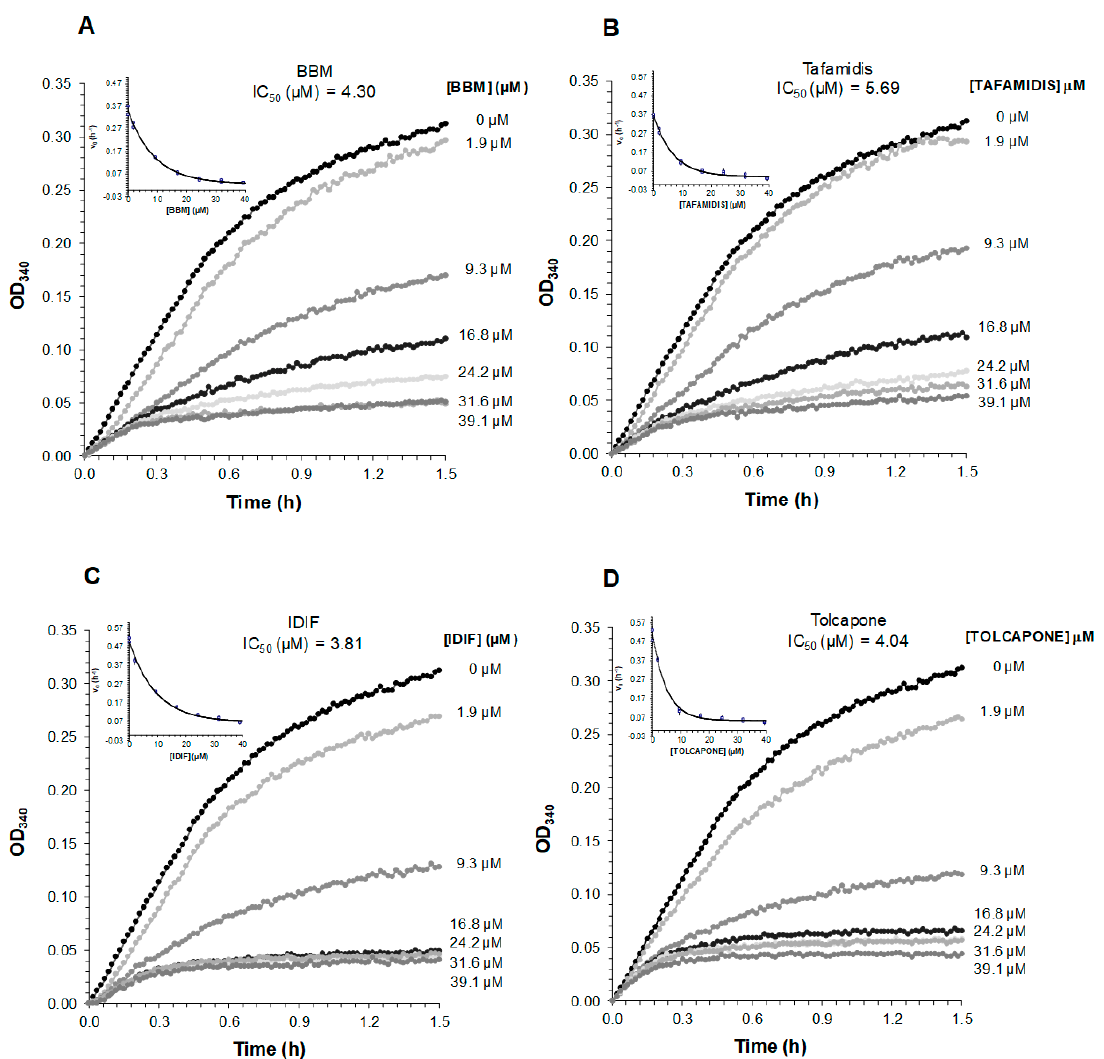
Figure 9. Time course of Y78F hTTR fibril formation at pH 4.2, 37 °C in the presence of different concentrations of: ( A ) BBM (inset: plot of initial rates of fibril formation (V0) vs. BBM concentration (Figure S1). Data were fitted to eq 1); ( B ) tafamidis (inset: plot of initial rates of fibril formation vs. tafamidis concentration) (Figure S2); ( C ) IDIF (inset: plot of initial rates of fibril formation vs. IDIF concentration) (Figure S4); and ( D ) tolcapone (inset: plot of initial rates of fibril formation vs. tolcapone concentration) (Figure S3).; for diflunisal (Figure S5); as monitored by absorbance at 340 nm at different concentrations. Experiments were performed in duplicate.